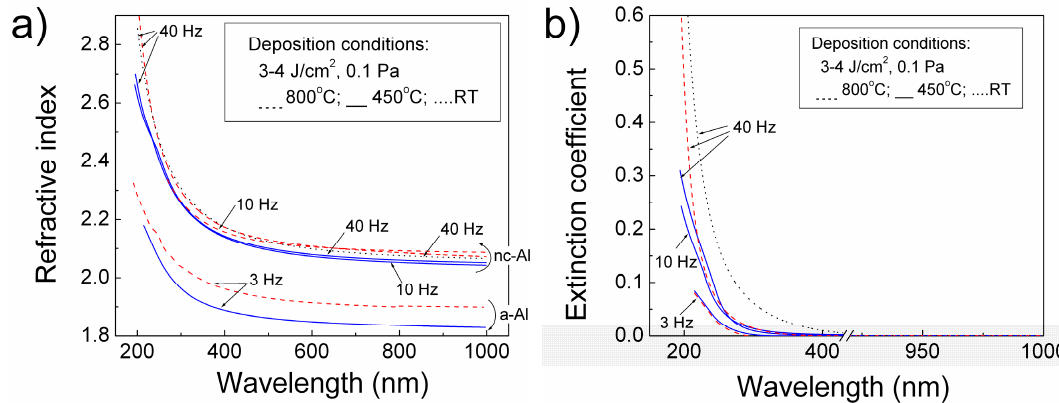
Figure 10. Dispersion curves of the refractive index ( a ) and extinction coefficient ( b ) of the studied AlN films deposited in the conditions presented in the insets. Table 2. SEM-EDS data for AlN films deposited at different substrate temperatures in ambient N 2 at